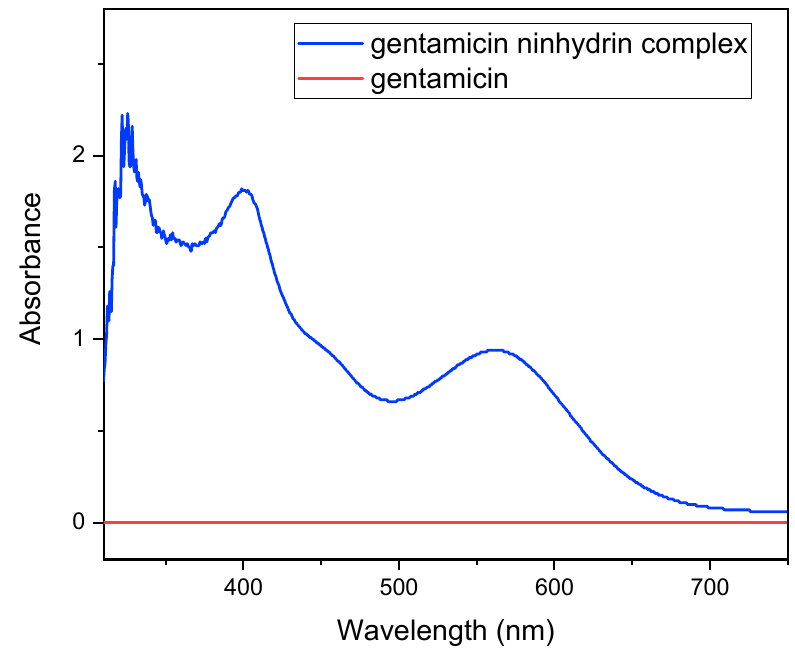
Figure 9. Spectrophotometric curve of gentamicin and the gentamicin–ninhydrin complex .